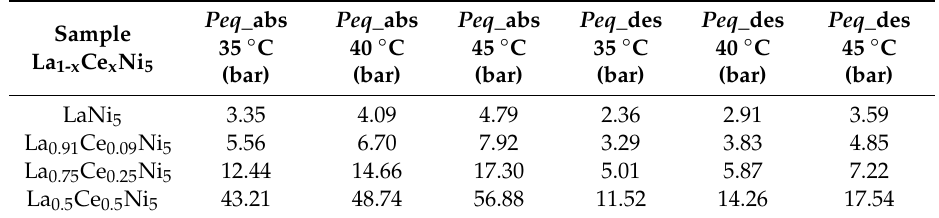
Table 2. Determined equilibrium pressures of the LaNi 5 , La 0.91 Ce 0.09 Ni 5 , La 0.75 Ce 0.25 Ni 5 and La 0.5 Ce 0.5 Ni 5 samples.